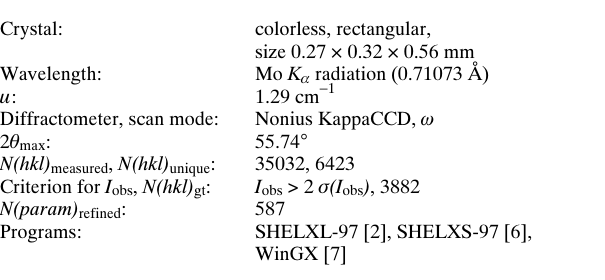
Table 1. Data collection and